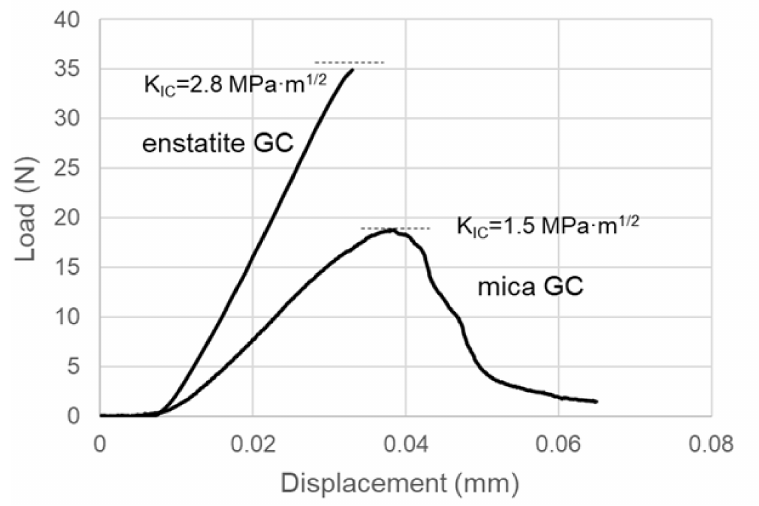
Figure 10. Load–displacement curves of the reference GCs during the three-point flexural tests.